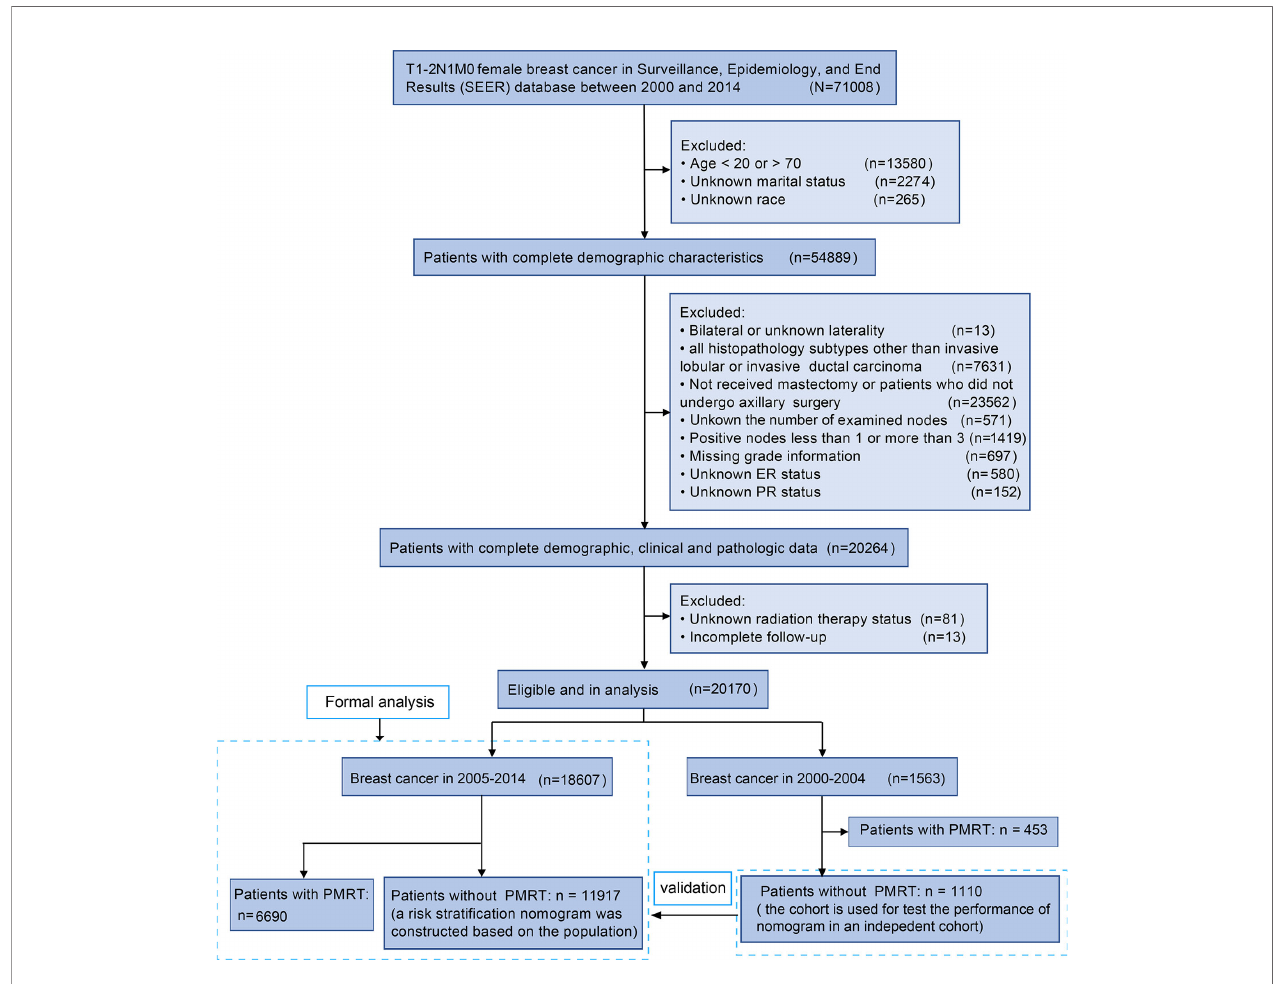
FIGURE 1 | Flowchart of the study design. A total of 20170 female T1 – 2 breast cancer with 1 – 3 positive axillary lymph nodes were fi nally involved in our